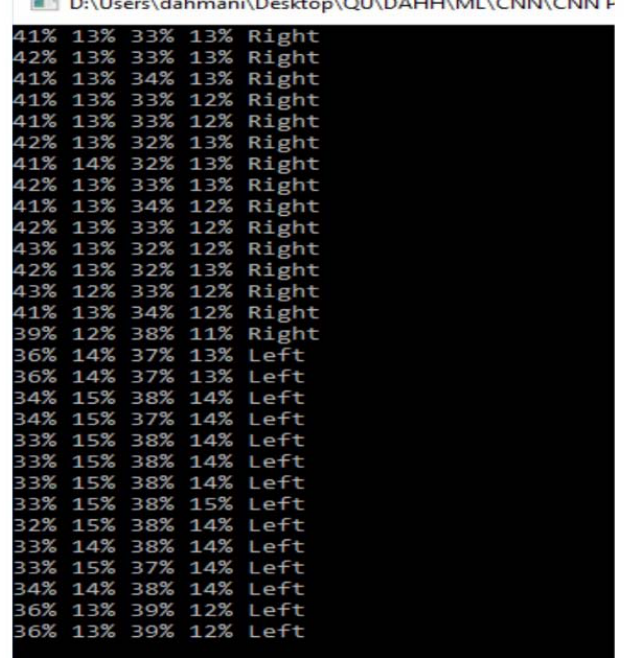
Figure 18. Real time prediction results.